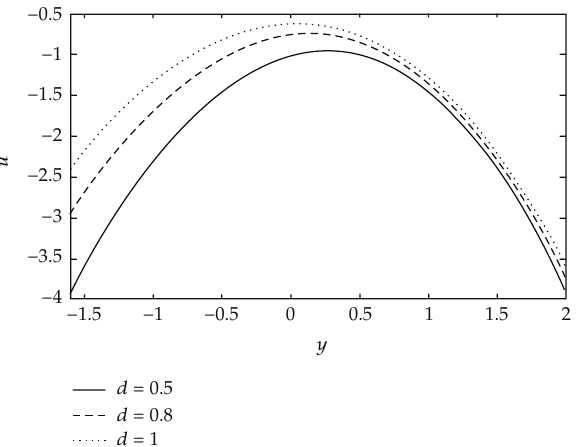
Figure 12: Axial velocity versus y at α (cid:9) 0 . 05, a (cid:9) 0 . 2, b (cid:9) 0 . 6, q (cid:9) − 1, ε (cid:9) 0 . 2, λ 1 (cid:9) 1, Da (cid:9) 1, x (cid:9) π/ 6, and φ (cid:9) π/